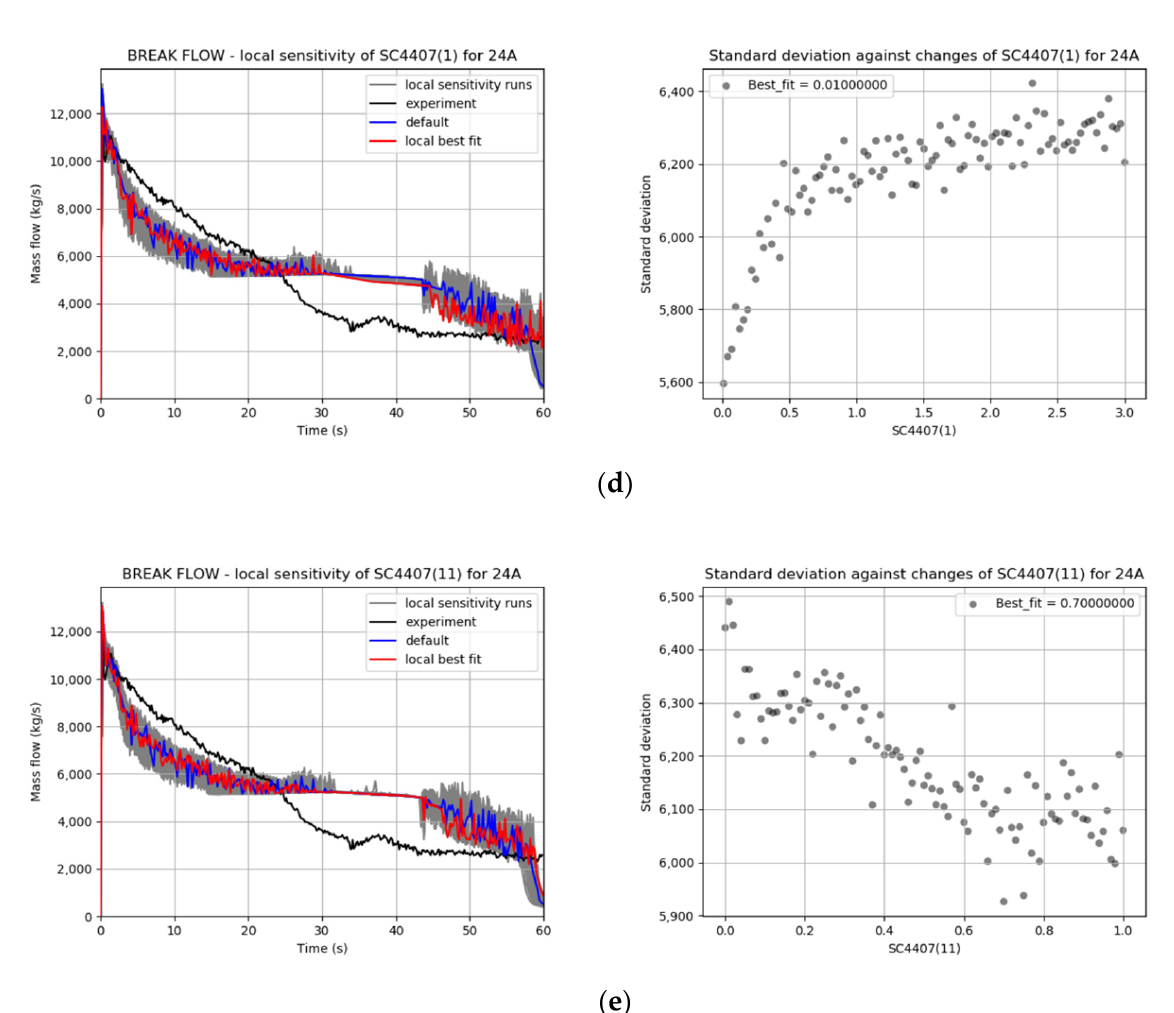
Figure 10. The local sensitivity analysis for the chosen parameters for the 24A nodalization. ( a – e ) Different parameters: left—break flow and right—standard deviation for the best-fit approach. CDCHKF_FL—Discharge Factor, SC4402(1)—Choking velocity limit, SC4402(2)—Moody model multiplication factor, SC4407(1)—Bubble rise velocity, and SC4407(11)—Maximum void fraction.